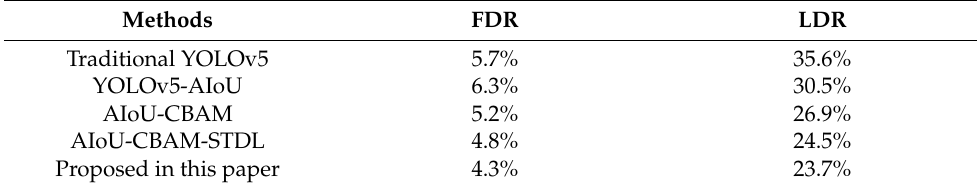
Figure 14. Comparison of persimmon detection with the different improved models. Table 4. Fault detection rates and omission rates of each